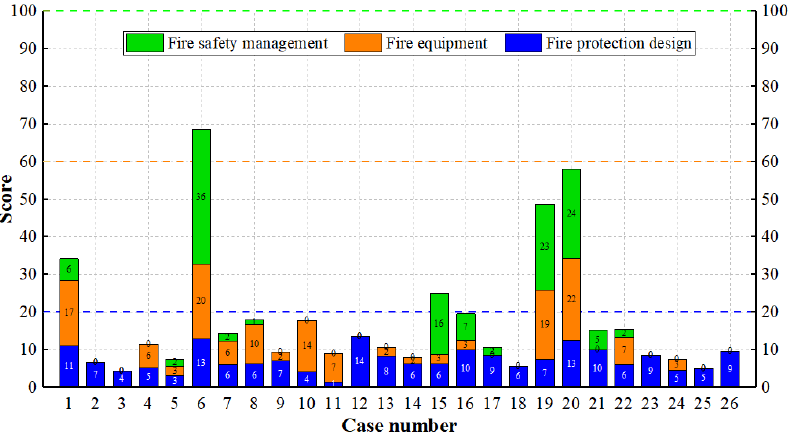
Figure 4. Safety scores of burning cases in IS. Fire equipment and fire safety management are seri- ously lacking in some